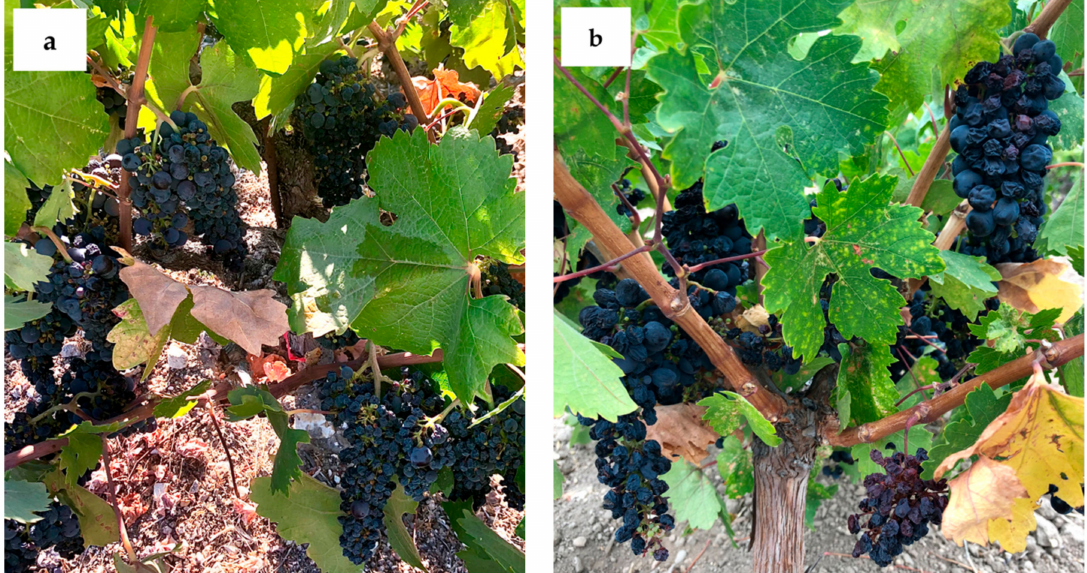
Figure 5. Berry water loss and sunburn symptoms in Young vines during the ( a ) 2019 and ( b ) 2020 growing season. Symptoms were pictured on 20 September 2019 (43 days post-v é raison) compared to 2 September 2020 (34 days post- v é raison). The second heatwave in 2020 occurred two days after this picture was